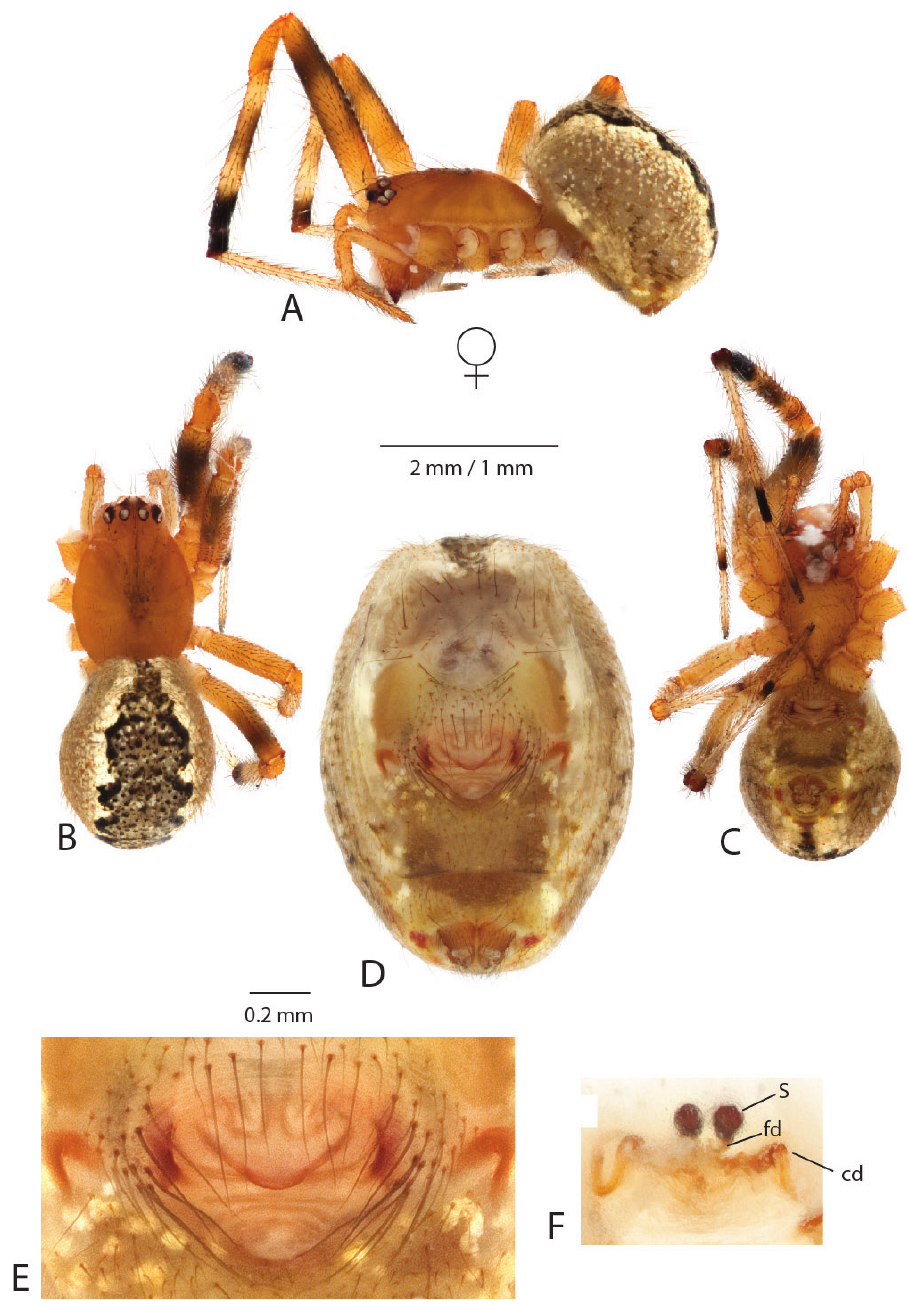
Figure 10. Anelosimus tita : A–D female lateral, dorsal, ventral, and ventral abdomen E epigynum ventral F epigynum cleared,